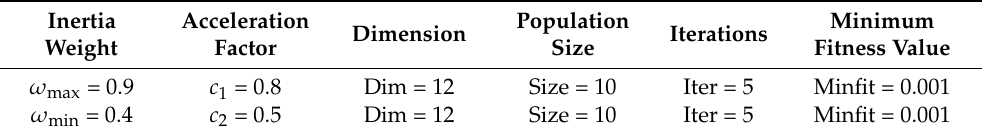
Table 3. Main parameters of PSO algorithm.